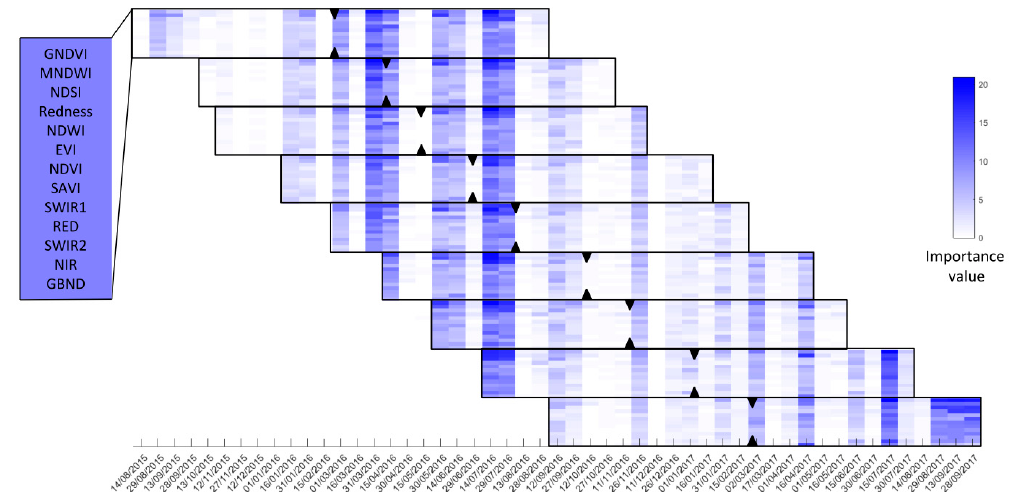
Figure 7. Importance of the predictors for each prediction date. X-axis represents the dates of Landsat image composites. Y-axis represents the 13 spectral indices and individual bands used, repeated 9 times for the 9 predicted dates. Vegetation indices, defined in Table 2, are represented in the order written on the left, for each prediction date (in the decreasing order of average importance across all Landsat images and prediction dates, from top to bottom). All predictors used for a prediction date are located within the same black box, and the prediction date is shown as triangle marks.